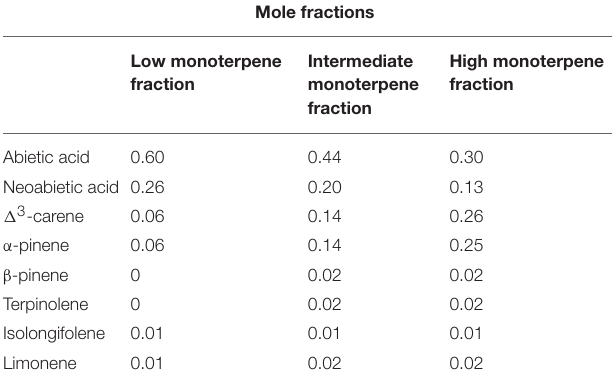
TABLE 2 | Simplified resin mixtures used in COSMOtherm